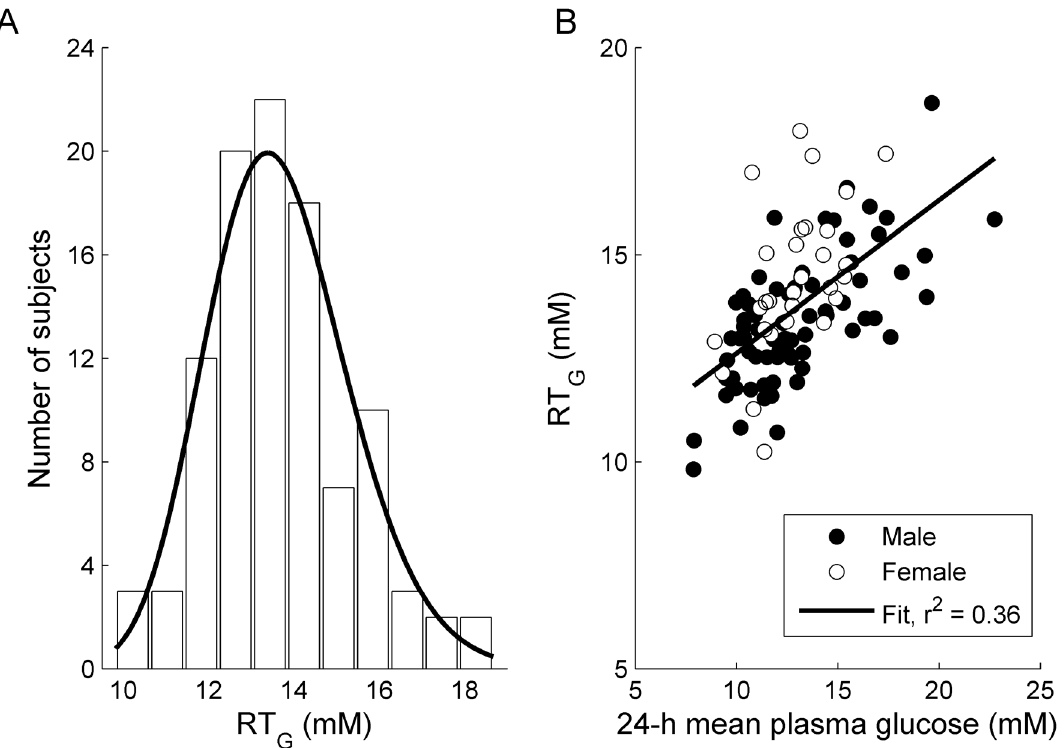
Figure 3. Relationship between baseline 24-hour mean RT G and 24-hour mean PG. (A) Distribution of 24-hour mean RT G values at baseline and (B) correlation between RT G and 24-hour mean PG prior to canagliflozin treatment. RT G , renal threshold for glucose; PG, plasma glucose.